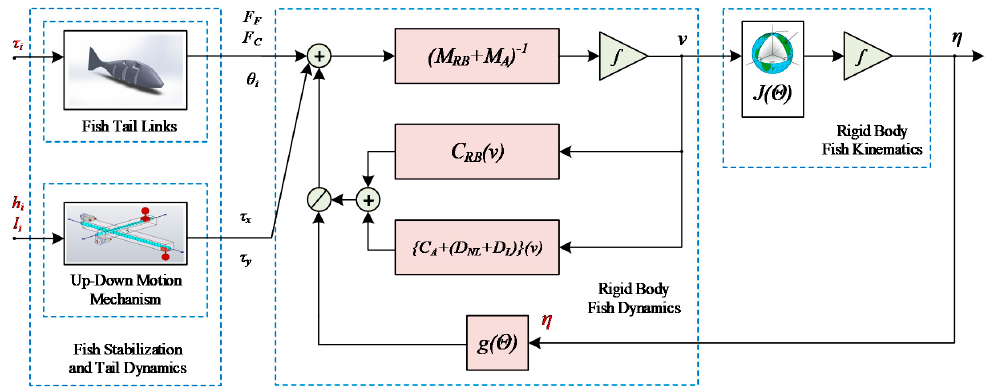
Figure 10. 6-DoF motion block diagram.